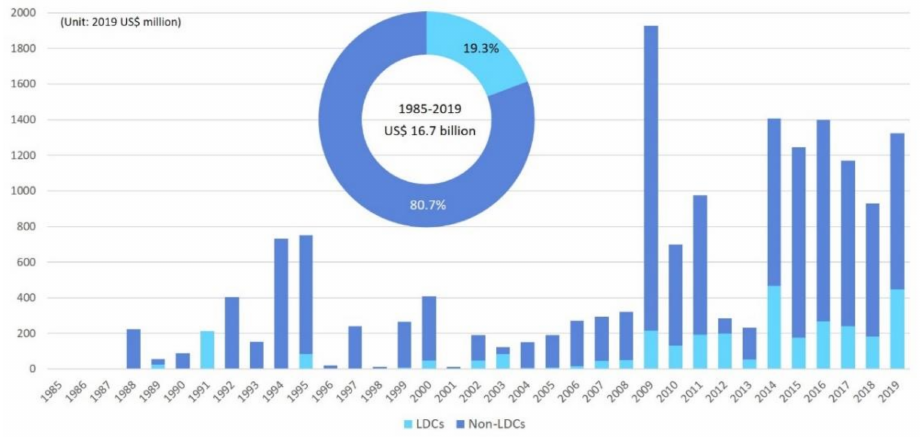
Figure 10. NHRE finance in LDCs and non-LDCs (1985–2019). Source: authors’ illustration based on